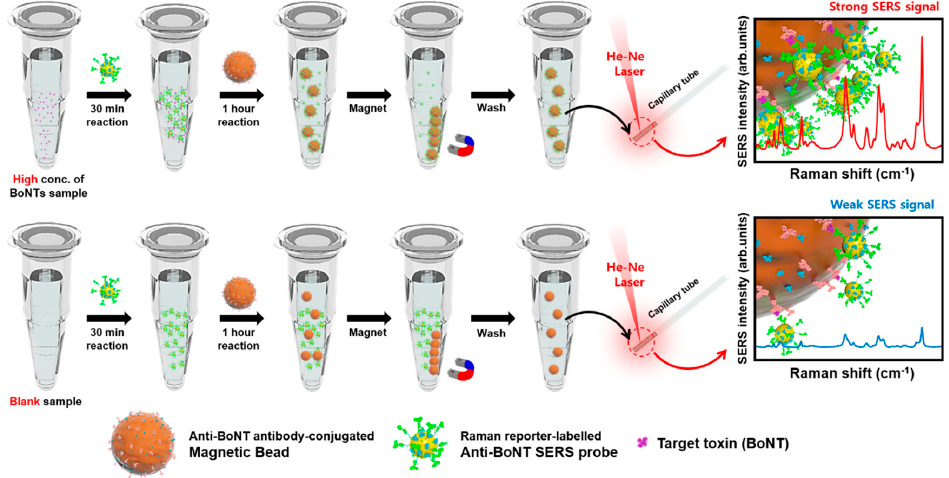
Figure 3. Schematic illustration of the sequential SERS-based immunoassay process, including mixing of BoNT toxin and BoNT antibody-conjugated magnetic beads, addition of BoNT antibody-conjugated SERS nanotags, separation of magnetic immunocomplexes, and SERS detection. Sensors 2019 , 19 , x In the present work, the strongest Raman peak intensities at 1614 cm − 1 (MGITC) and 1639 cm − 1 (NBA) were used for the quantitative evaluation of BoNT/A and BoNT/B toxins, respectively. Figure 4a,b shows the Raman spectra for various concentrations of BoNT/A and BoNT/B, respectively. Their concentrations varied from 0 ng/mL to 1.0 μ g/mLml. In the absence of BoNTs, weak Raman signals were observed owing to the formation of few immunocomplexes in the microtube; hence, most SERS nanotags in the supernatant solution were removed during washing. An increase in BoNT concentration, however, led to the formation of more immunocomplexes, as evident from the corresponding increase in Raman signal intensities. Figure 4c,d demonstrates the corresponding calibration curves for BoNT/A and BoNT/B, as constructed from the intensity variations at 1614 cm − 1 (MGITC) and 1639 cm − 1 (NBA), respectively. The error bars indicate standard deviations from the measurements for three immunocomplex replicas. The LODs, as determined with the SERS-based immunoassay method, were 5.7 ng/mL (R 2 = 0.999) and 1.3 ng/mL (R 2 = 0.999) for BoNT/A and BoNT/B, respectively.